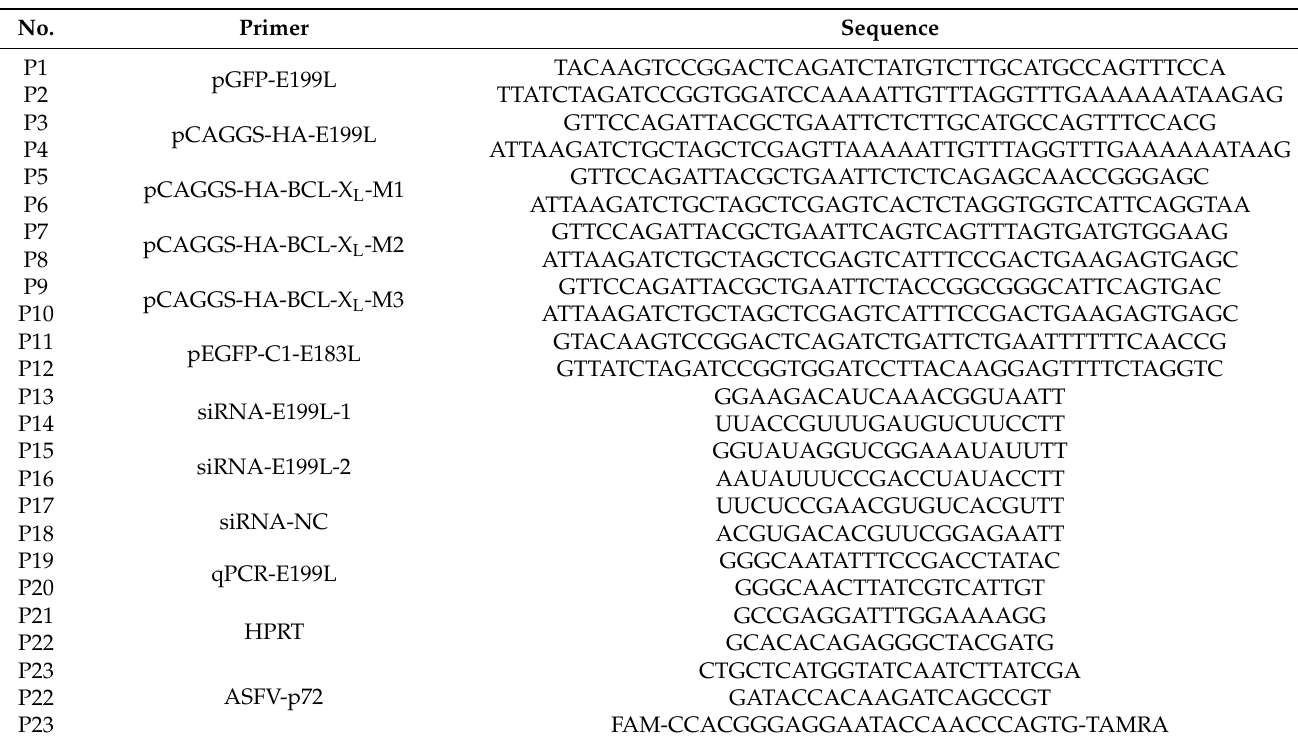
Table 1. The sequences of the primers used for